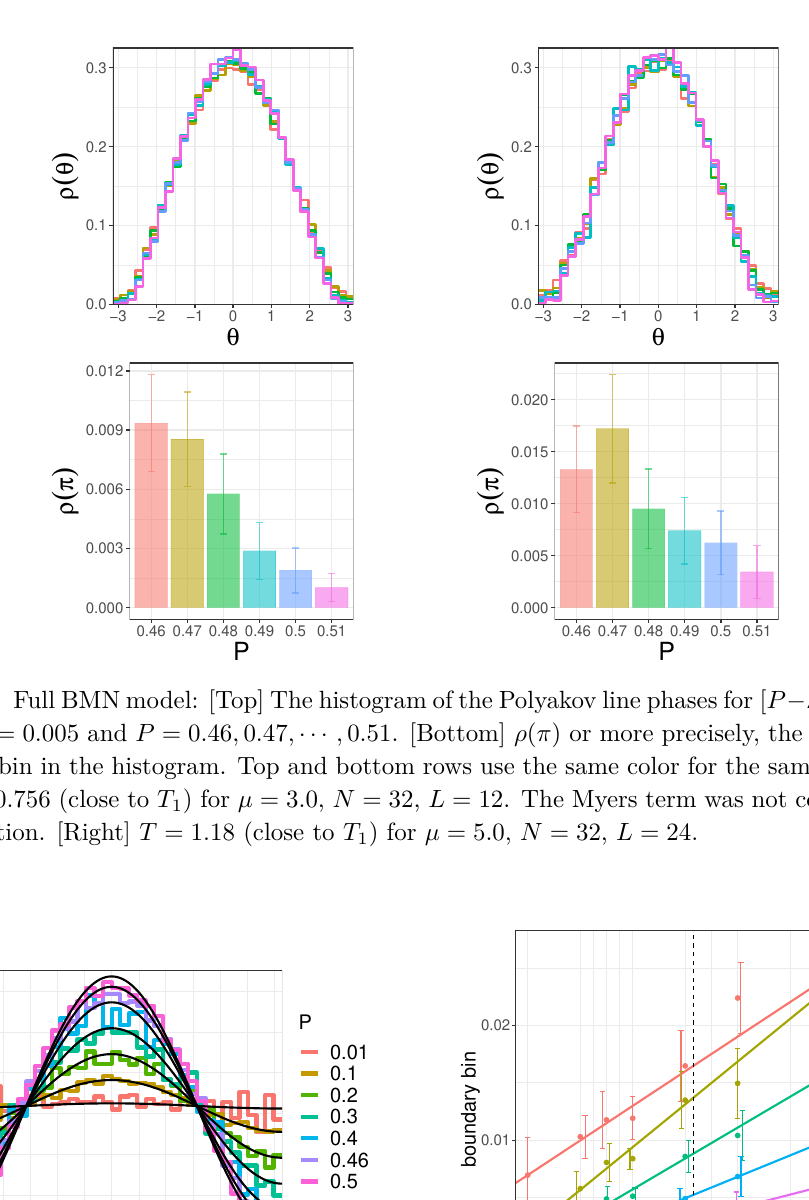
), matrix 1 is shown in black. A 2 π